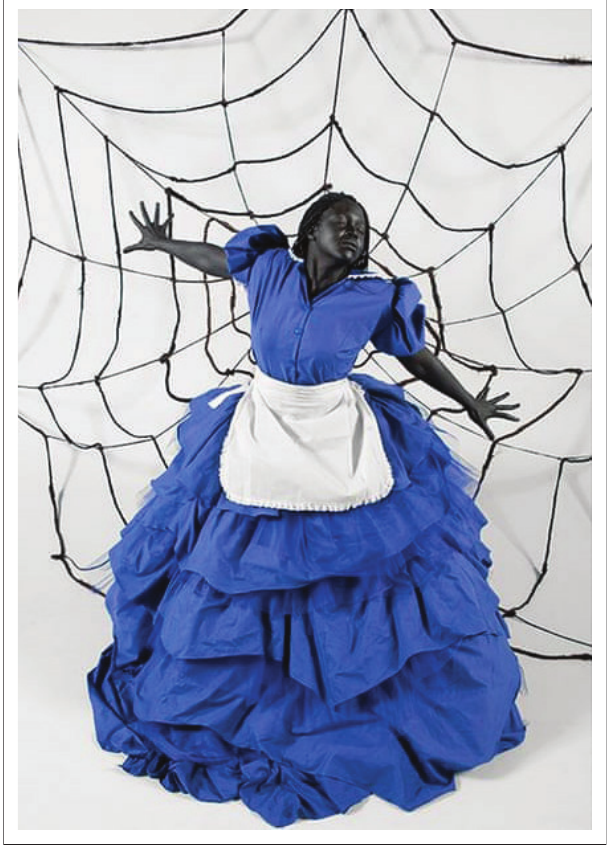
FIGURE 7: Spiderman – Sophie, Mary Sibande.